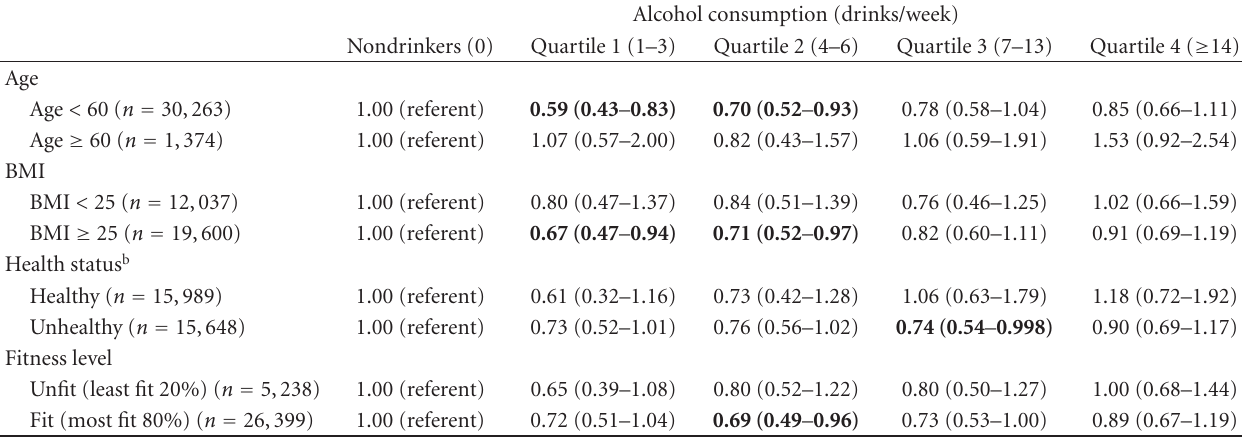
Table 5: Hazard ratios of CVD mortality stratified by risk factors a , Aerobics Center for Longitudinal Study (ACLS), 1974–2002.